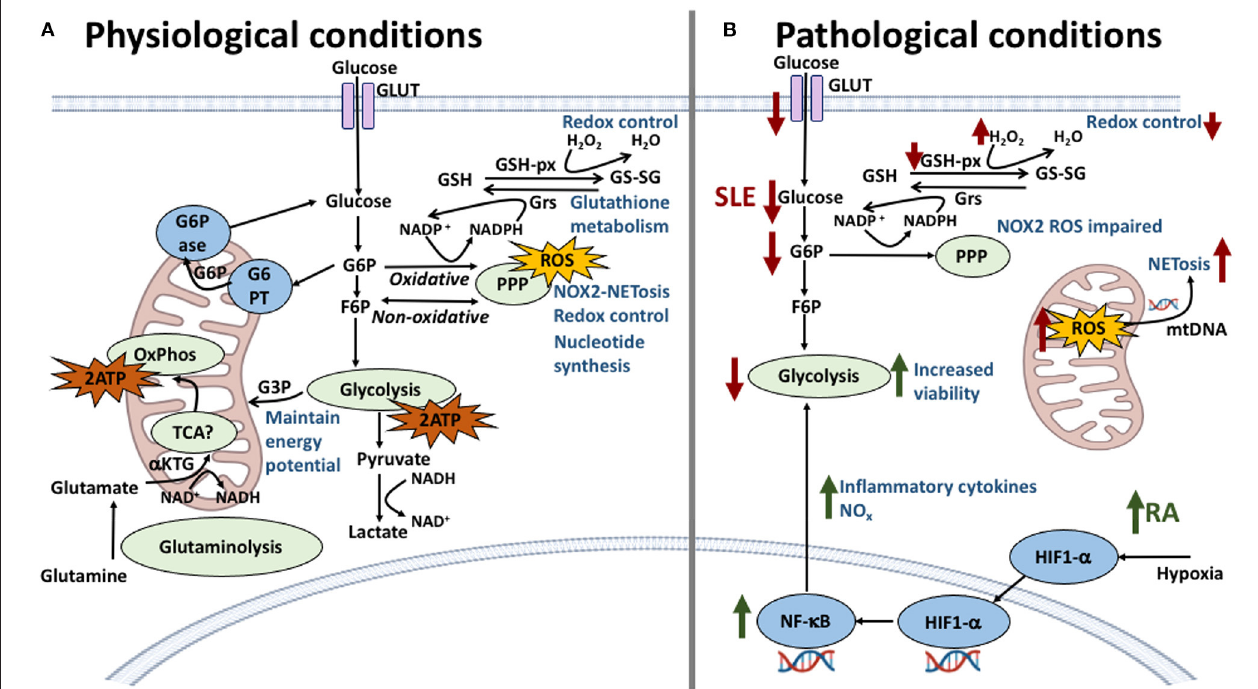
FIGURE 4 | Neutrophil metabolic pathways and the effect of their dysregulation in SLE and RA. (A) In physiological conditions, glycolysis is the main energy producing pathway utilized by neutrophils; intermediate metabolites G6P and F6P are starter molecules for the pentose phosphate pathway (PPP), important in redox control, NOX2-dependent NETosis and ROS production. The oxidative stage of PPP produces NADPH which is used in the glutathione metabolism to reduce glutathione providing further redox capacity. Other energy producing pathways have been described, previously thought to be non-functional, such as the TCA cycle which connects glutaminolysis pathway and further regulates NOX2 complex by generating the reducing equivalents of NADPH. (B) In SLE and RA dysregulation of these pathways is responsible for the conditions observed at the cellular level. In SLE (red arrows), a lower expression of glucose transporters is met with lower levels of intracellular glucose, diminishing the energy output by glycolysis and compromising cellular viability. Furthermore, a decrease of G6P intermediates correlates with lower levels of NOX2-dependent ROS and decreased redox capacity. NOX2-independent ROS production in mitochondria is amplified in SLE neutrophils with increasing release of NETs containing mitochondrial DNA. In RA (green arrows), the inflammatory environment and hypoxic conditions increase the expression of HIF1- α which upregulates key glycolytic enzymes increasing energy production and viability. HIF1- α also is an upstream regulator of NF- κ B which increases pro-inflammatory cytokine production therefore maintaining the inflammatory